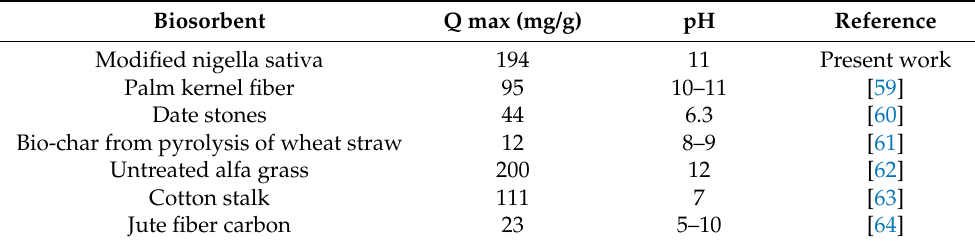
Table 4. Comparison of obtained maximum removal amount of MB (qm) with those previously